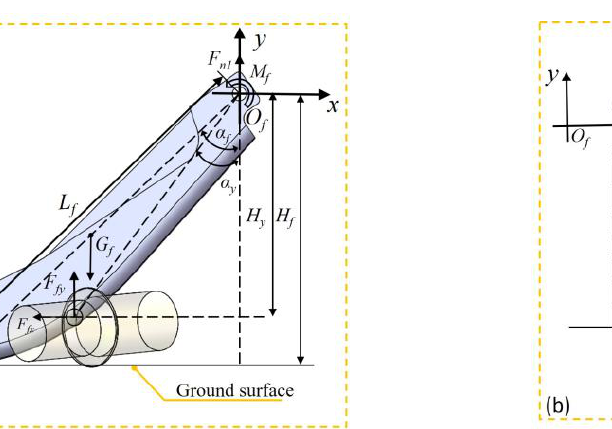
where F n2 is the supporting force of ground surface against corn straw, N; F f2 is the friction force of ground surface against corn straw, N; G f is the weight of corn straw, N; F (cid:48) fy is the component force of profiling plate on corn straw along y -axis direction, N; F (cid:48) fz is the component force of profiling plate on corn straw along z -axis direction, N; α j is the cutting edge angle of profiling plate, ◦ ; and µ 0 is the friction coefficient between corn straw and ground surface. Combining Equations (3) and (4), the torque value applied at the fixed shaft can be obtained through Equation (5).